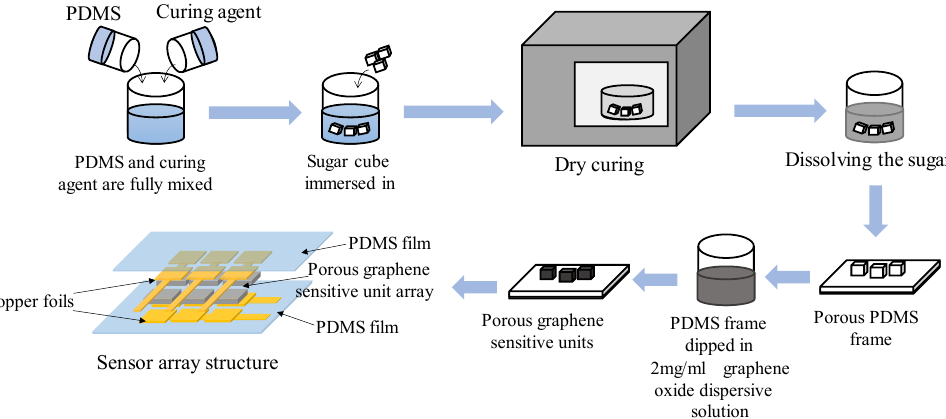
Figure 2. Fabrication procedure of the porous graphene flexible tactile sensor array.